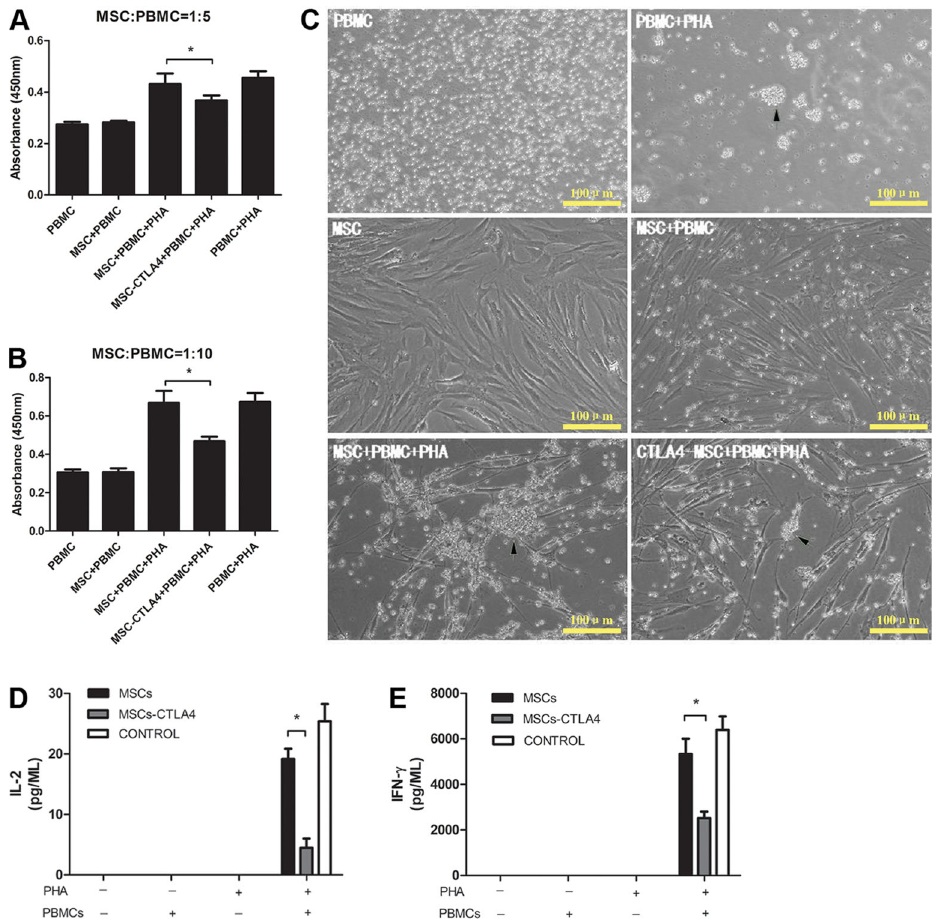
Figure 2. Proliferation and activation of T lymphocytes in the presence of mesenchymal stem cells (MSCs) and MSCs-CTLA4. g -irradiated MSCs-CTLA4 or MSCs were cocultured with peripheral blood mononuclear cells (PBMCs) at a ratio of 1:5 ( A ) or 1:10 ( B ) in the presence or absence of 2.5 m g/mL phytohemagglutinin (PHA). Cell proliferation was measured by CCK-8 assay. Data are reported as the absorbance values of each group. C , Representative light microscope image (magni fi cation 100 (cid:1) ). D and E , Levels of interleukin (IL)-2 and interferon (IFN)- g in supernatants. Data are reported as means ± SD. *P o 0.05 (Student ’ s t